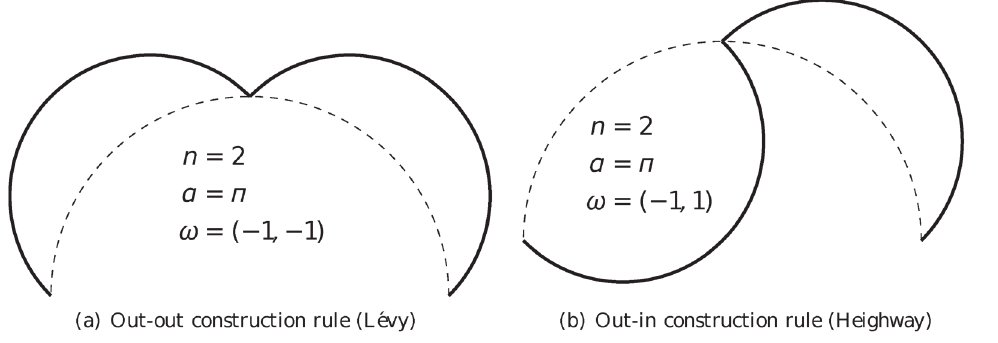
Fig 9. Construction rules of 2-arc